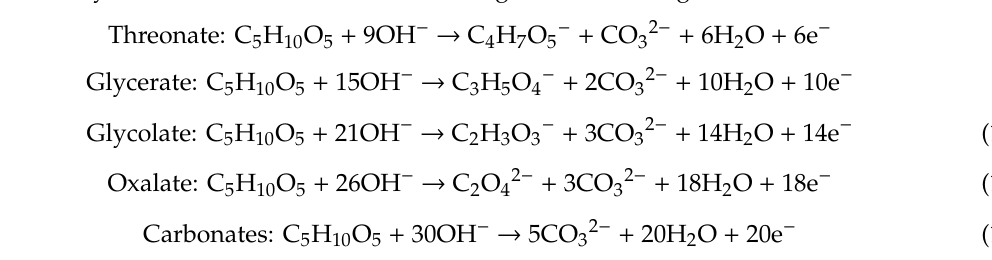
Table3. Experimentaldataforxyloseelectro-reforming: cellvoltages( U cell ), initialxyloseconcentrations ( C glucose, i ), coulombic charges involved ( Q ), corresponding xylonate concentrations if two electrons are exchanged per xylose molecule oxidized ( C CA ), xylonate concentrations determined by HPLC ( C HPLC ) and faradaic yields ( η F